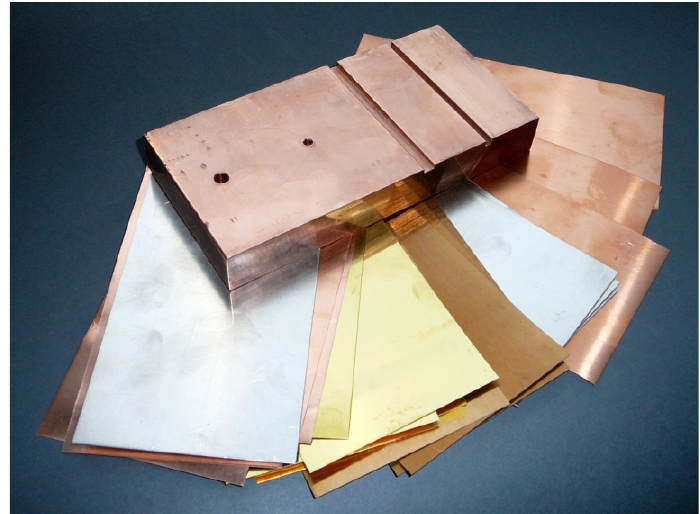
Figure 1. Samples for eddy current testing in the form of a thick plate made of copper (thickness 20 mm) and thin foils made of various types of conductive materials (thicknesses ranging from 0.1 mm to 0.5 mm).